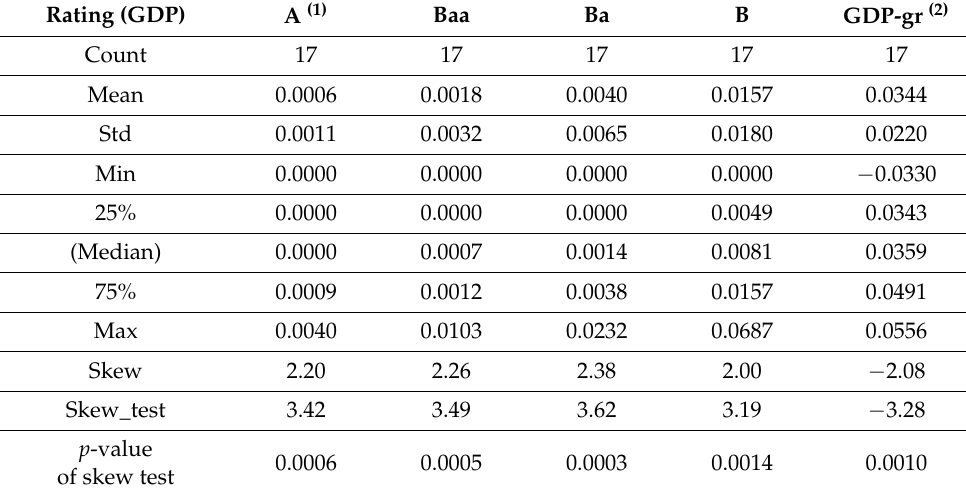
Table 1. Descriptive statistics of GDP and default rates for ratings A, Baa, Ba, and B.